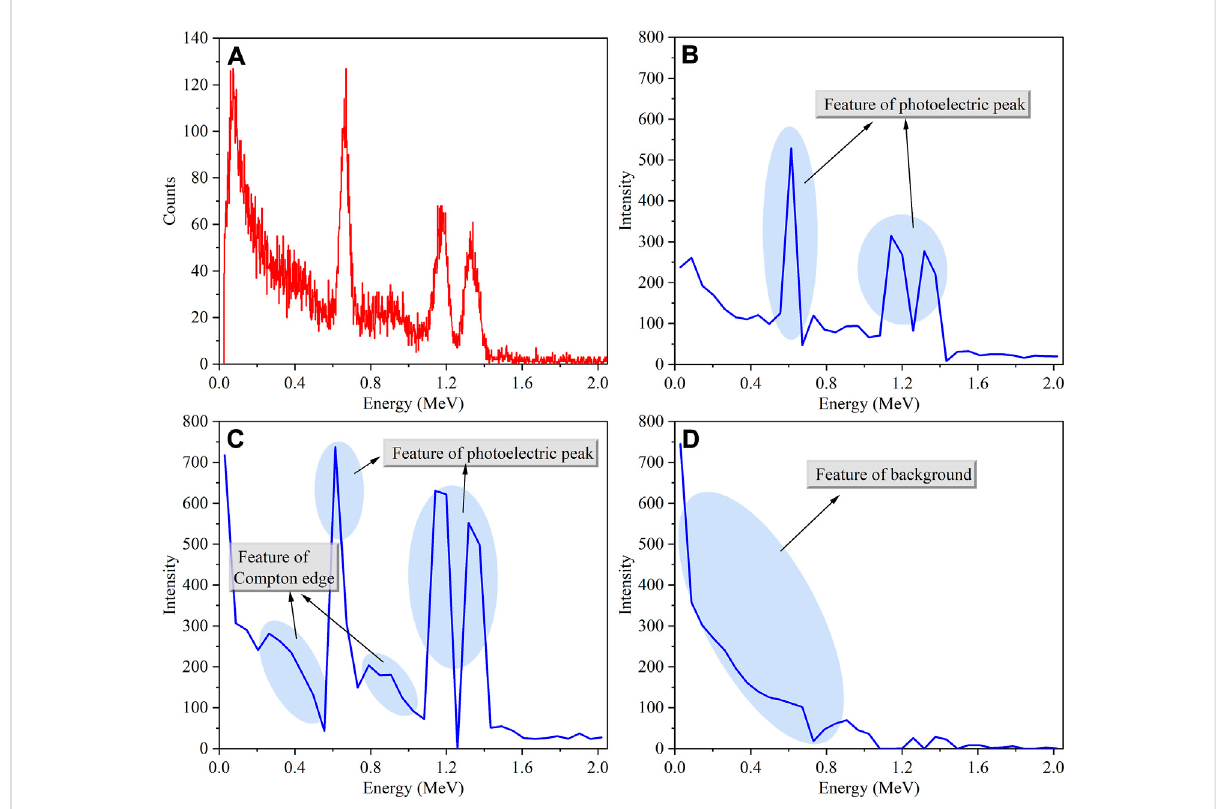
FIGURE 9 Examples of mixed nuclides of 60 Co and 137 Cs; (A) original gamma-ray spectrum, (B) feature map 1, (C) feature map 2, (D) feature map 3.